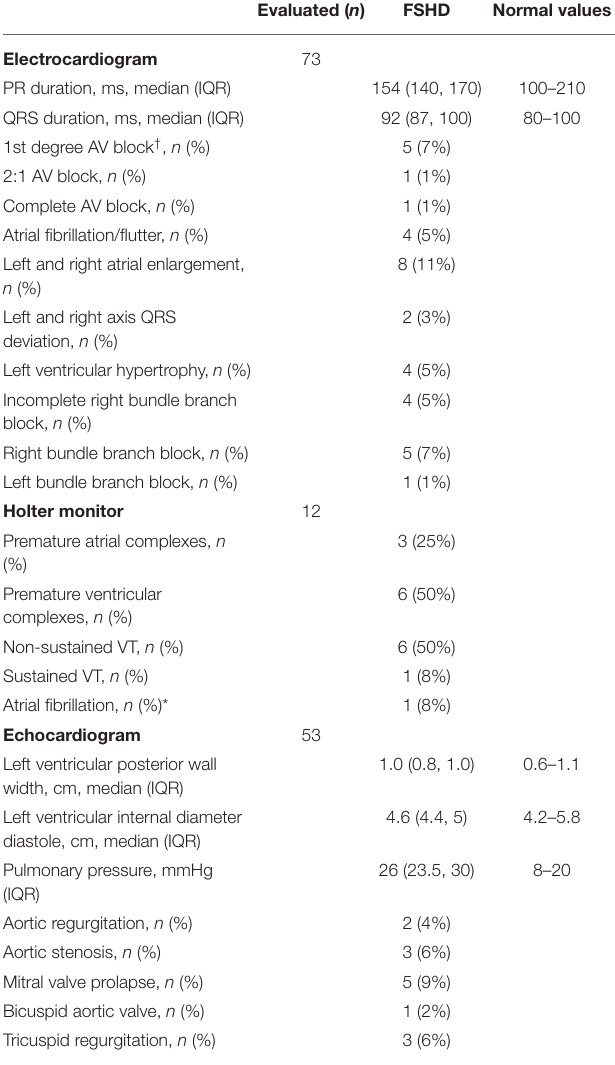
TABLE 2 | Cardiovascular findings in facioscapulohumeral muscular dystrophy (FSHD) type 1 and 2 patients.